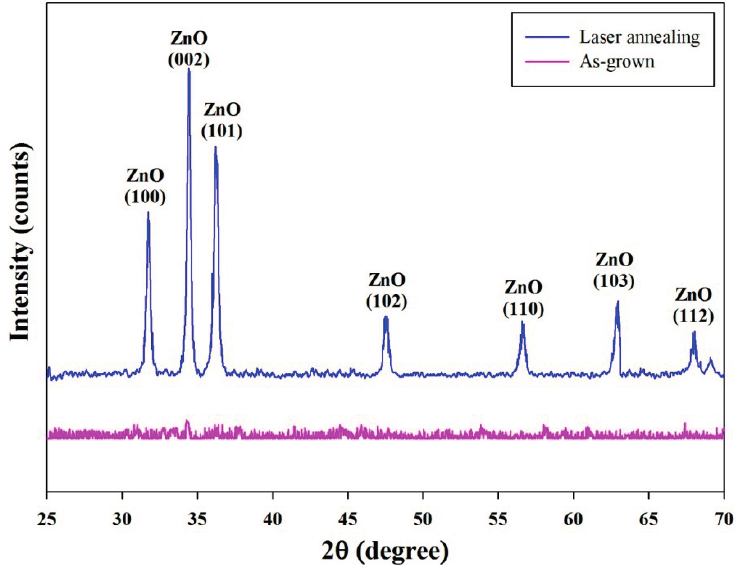
Figure 7. The XRD pattern of the aerosol deposited ZnO